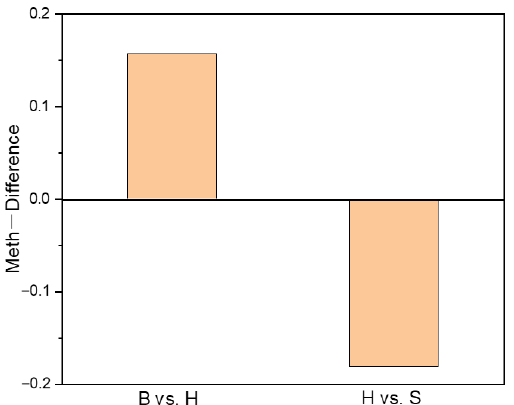
Figure 5. The methylation level of mannuronate C5-epimerase (MC5E) genes (Gene ID: EVM0008148) in the “B vs. H” and “H vs. S” groups. The positive value of methylation level represents the hypermethylation condition, and the negative value of methylation level represents the hypomethylation condition. B, H and S are the samples of blade, holdfast and stipe, respectively.